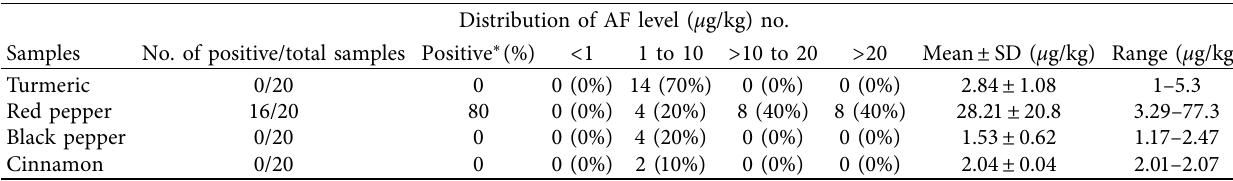
Table 2: Concentration distribution of AFs.